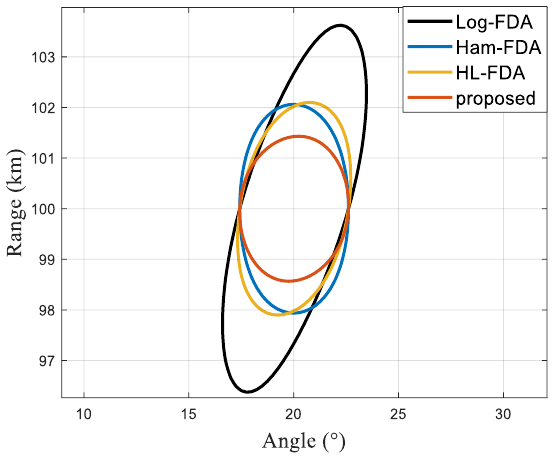
Figure 7. Half-power beamwidth diagram.